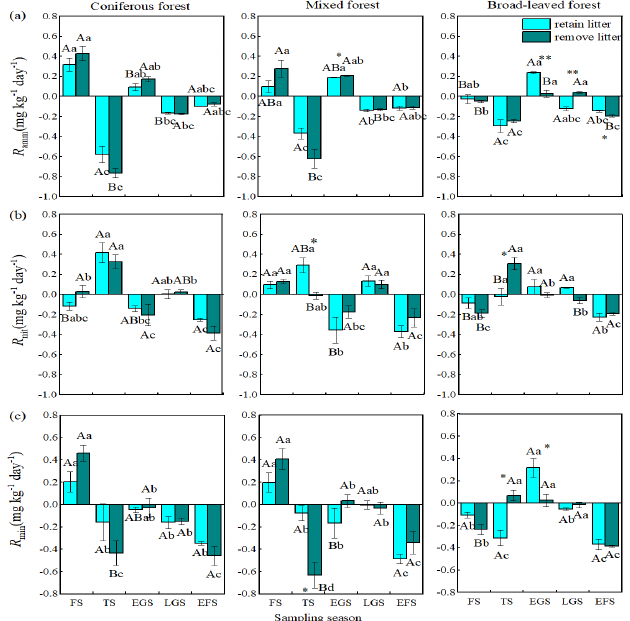
Figure 3. Effects of litter treatment on the net ammonification ( a ), nitrification ( b ) and mineralization ( c ) rates at different incubation stages in coniferous, mixed, and broad-leaved forests. Values indicate the means ± standard error, n = 3. FS: freezing season, TS: thawing season, EGS: early growing season, LGS: late growing season, EFS: early freezing season. Asterisks represent the significant differences between different litter treatments in the same forest type and sampling season. Lowercase letters represent the significant differences among different sampling seasons in the same litter treat- ment and forest type. Uppercase letters represent significant differences among the different forest types in the same litter treatment and sampling season.